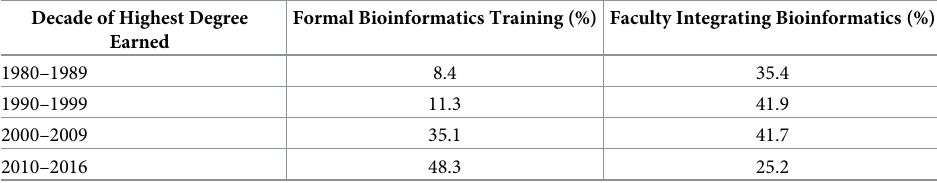
Table 4. Characteristics of faculty cohorts stratified by degree